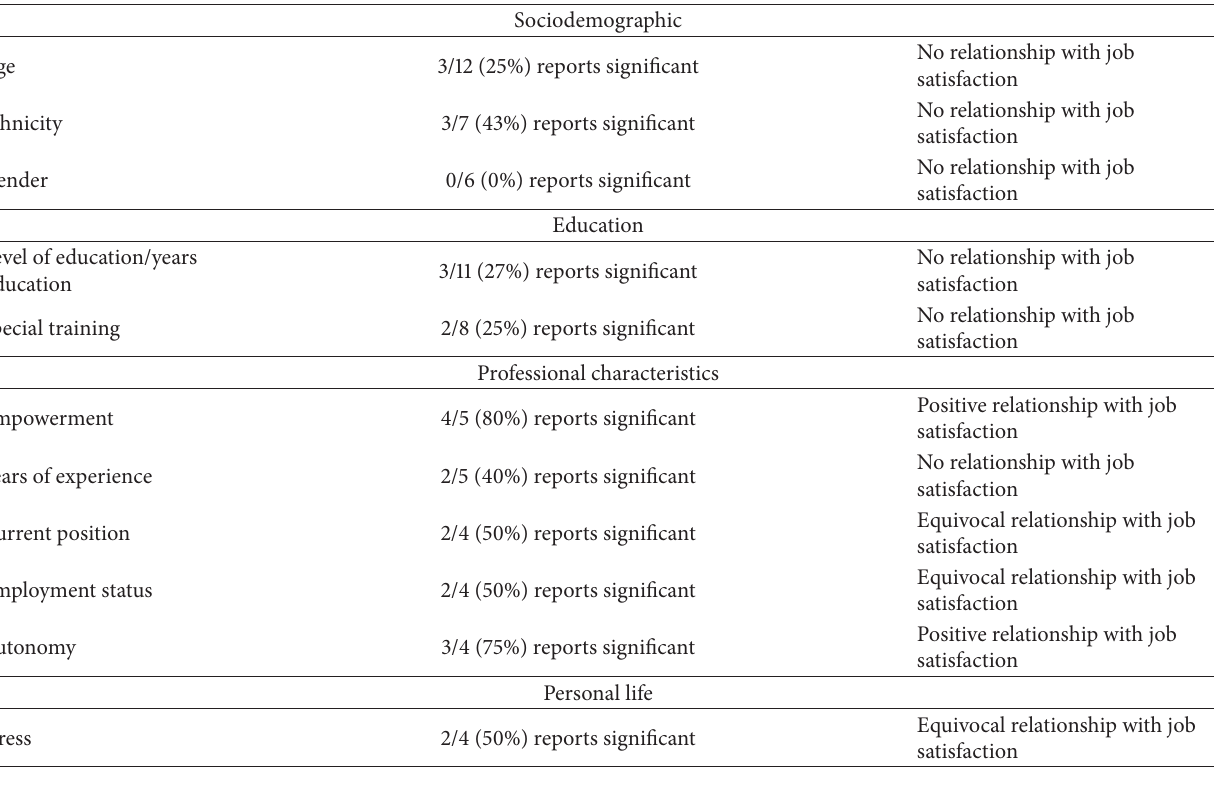
Table 5: Individual factor conclusions.